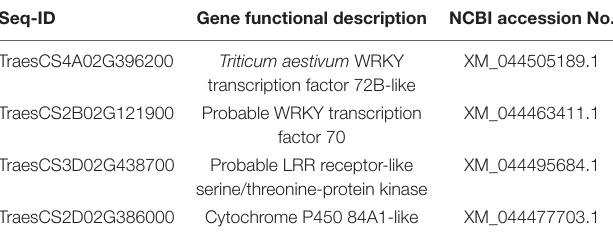
results were consistent with previous studies that P.